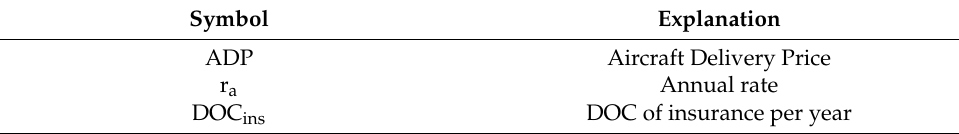
Table 3. Insurance cost symbols explanation.